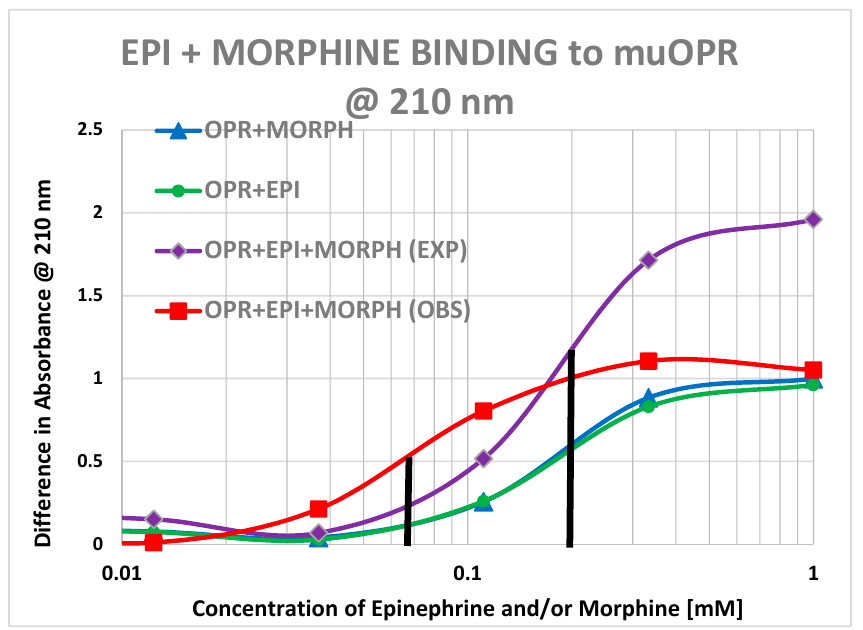
Figure 19. Mu opioid receptor (OPR) binding curves with morphine, epinephrine (EPI) and their combination (MORPH + EPI) at 210 nm. The choice of 210 nm is explained in Figure 10. The experimentally observed binding curve (PR + MORPH + EPI (OBS)) is compared with the theoretically predicted binding calculated from individual binding of MORPH to OPR and EPI to OPR (OPR + MORPH + EPI (EXP)). There is a half-log unit shift to the left (black vertical lines) in the observed binding as compared with the predicted binding.